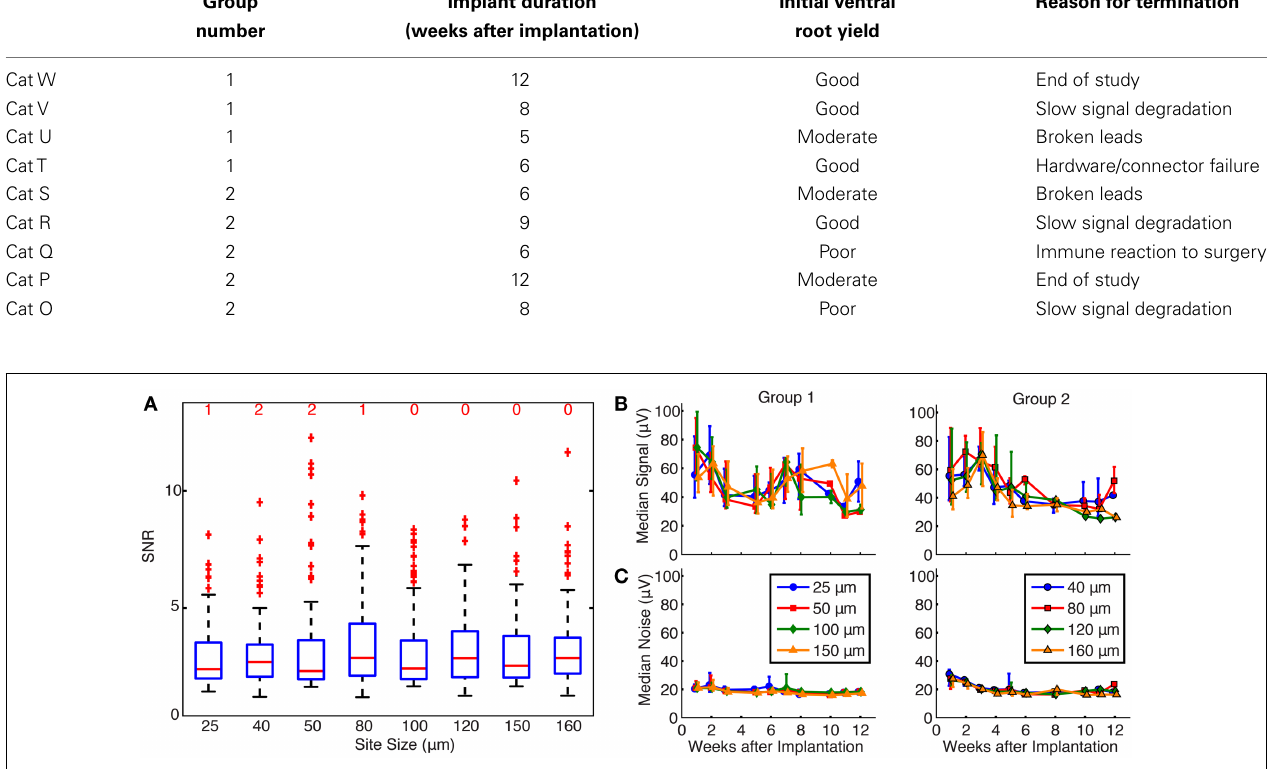
site size on SNR ( p = 0.56). (B) Signal calculated over time for each site size. Median signal amplitude decreased over time for all site sizes, and site size was not a significant factor upon signal amplitude ( p = 0.47 and 0.45 for groups 1 and 2, respectively). (C) Noise calculated over time for each site size. Median noise remained at approximately 20 µ V for the duration of the implants, and site size did contribute to noise in group 1 electrodes ( p < 0.01), but not group 2 electrodes ( p =